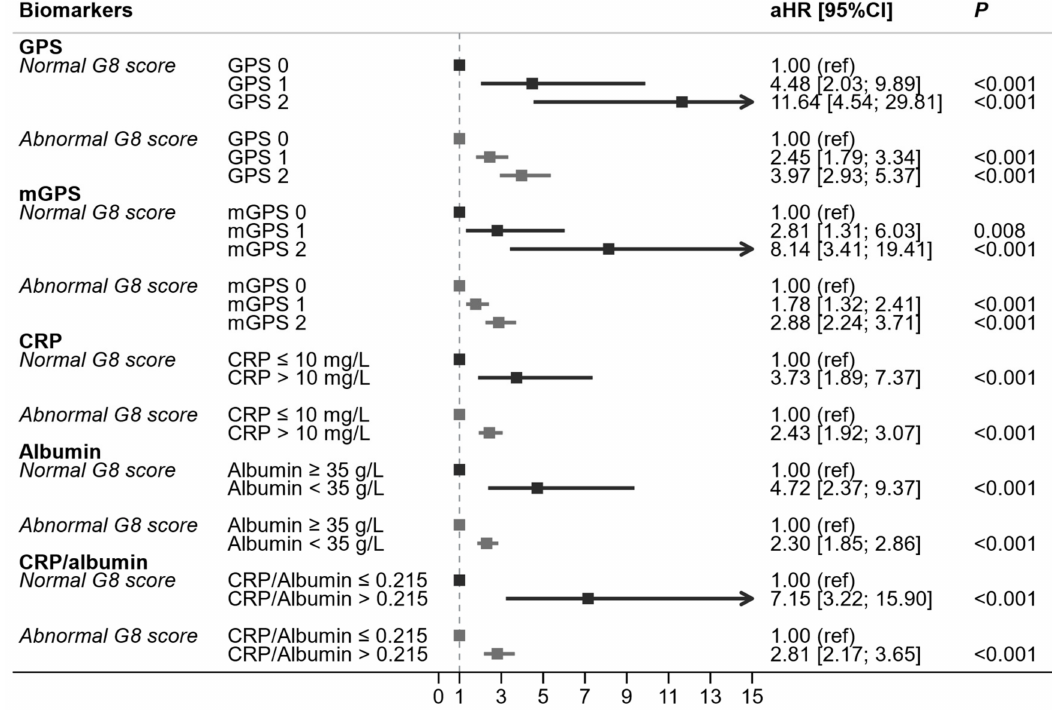
Figure 2. Multivariable analysis of GPS, mGPS, CRP, albumin and CRP/albumin ratio with regard to one-year mortality ( n = 1604).